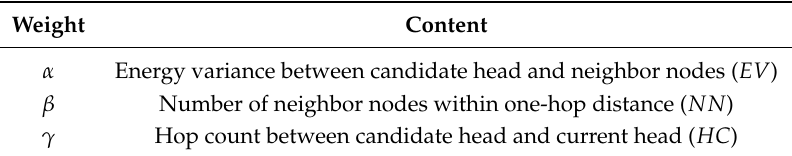
Table 3. Weighting factors for the cluster head